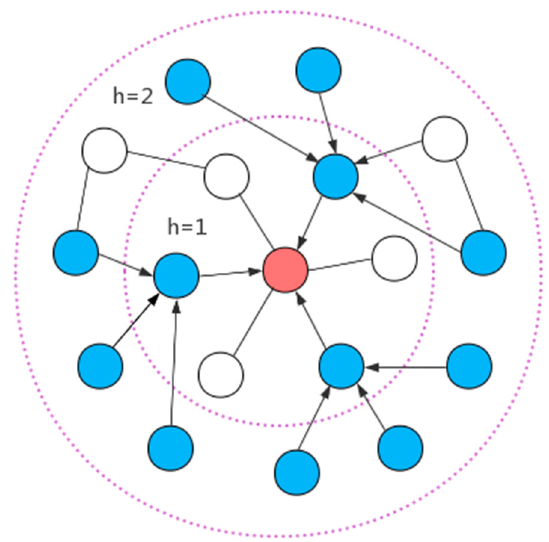
Figure 2. KGCN Model Diagram: the red circle represents the target project, the blue circles represent the extracted neighboring nodes, and the white circles represent the unextracted neighboring nodes.